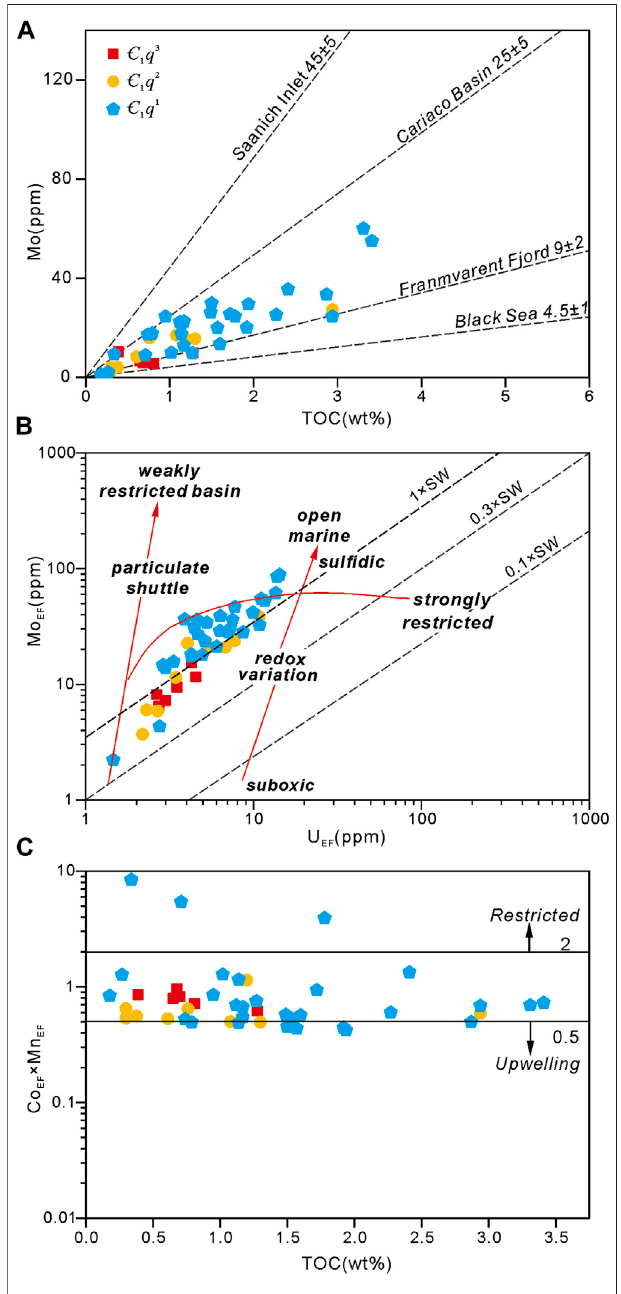
FIGURE6|(A) FortheEarlyCambrianintheQiongzhusiFm,W207Well, upslope area of Yangtze Platform, compared with generalized patterns of sedimentary Mo-TOC covariation associated with deepwater renewal in silled anxic basins (eg., Black Sea, Framvaren Fjord, Cariaco Basin and Saanich Inlet) ((Algeo and Lyons, 2006). (B) Euxinic conditions indicated by U EF vs. Mo EF during the deposition of the early Cambrian Qiongzhusi Fm, SW Sichuan Basin. Dotted lines show MoEF/UEF ratios equal to the seawater (SW)value(i.e.,1×SW)and fractionsthereof(0.3×SW,and0.1×SW)(Algeo and Tribovillard, 2009). (C) Crossplots of Co EF × Mn EF vs. TOC for the QiongzhusiFm in theW207 Well. Themodel dataisfrom Sweereet al.(2016). Є 1 ’ 2,3 : fi rst, second and third member of the Qiongzhusi 1 q